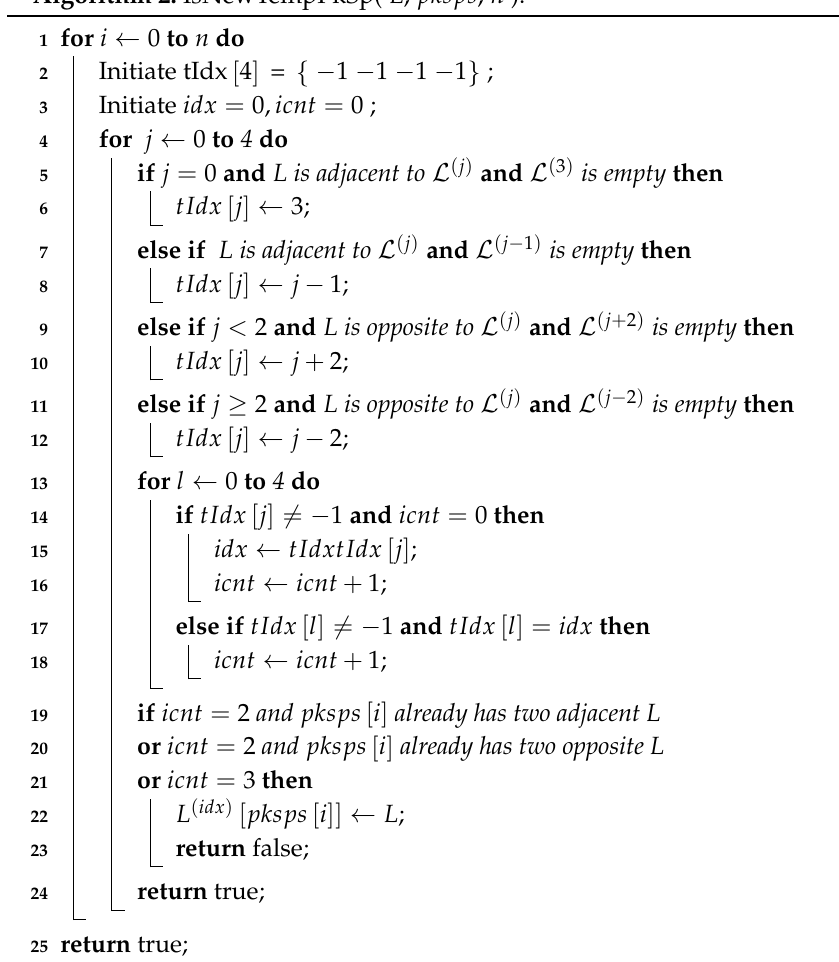
Algorithm 2: IsNewTempPkSp( L , pksps , n